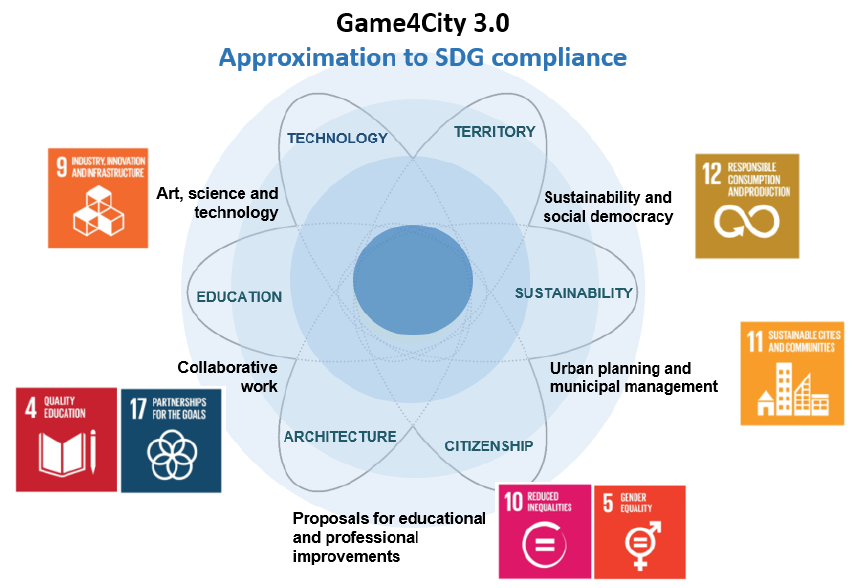
Figure 2. Game4City project scopes, lines of action and their relationship with SDGs.